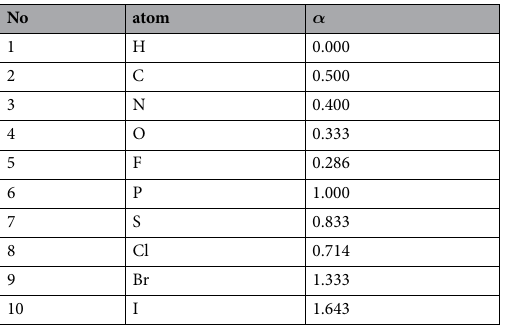
Table 4. The list of α of atoms commonly occurring in organic